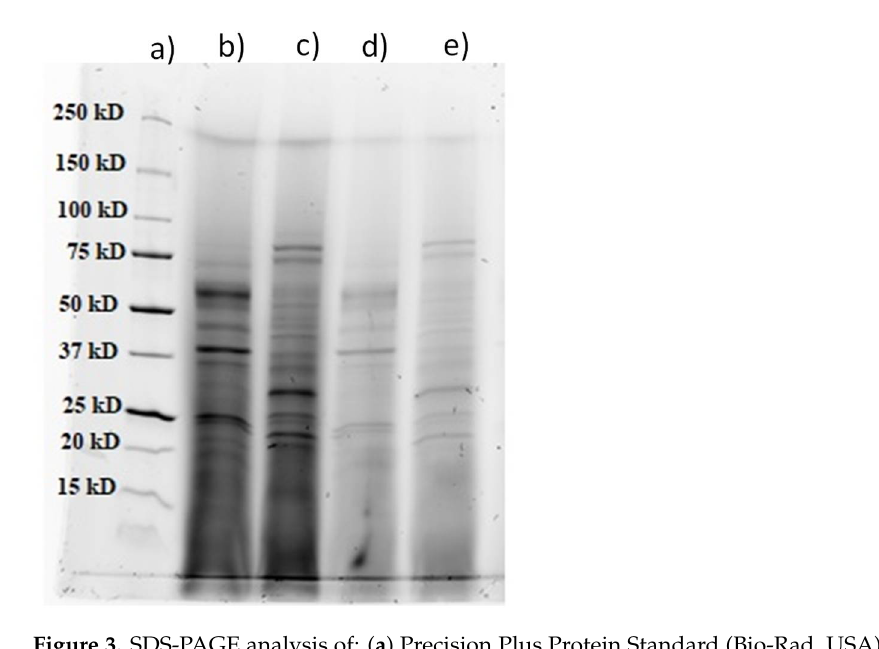
Figure 3. SDS-PAGE analysis of: ( a ) Precision Plus Protein Standard (Bio-Rad, USA), ( b ) partially purified extracts of FO , ( c ) partially purified extracts of FV , ( d ) crude extract of FO , and ( e ) crude extract of FV